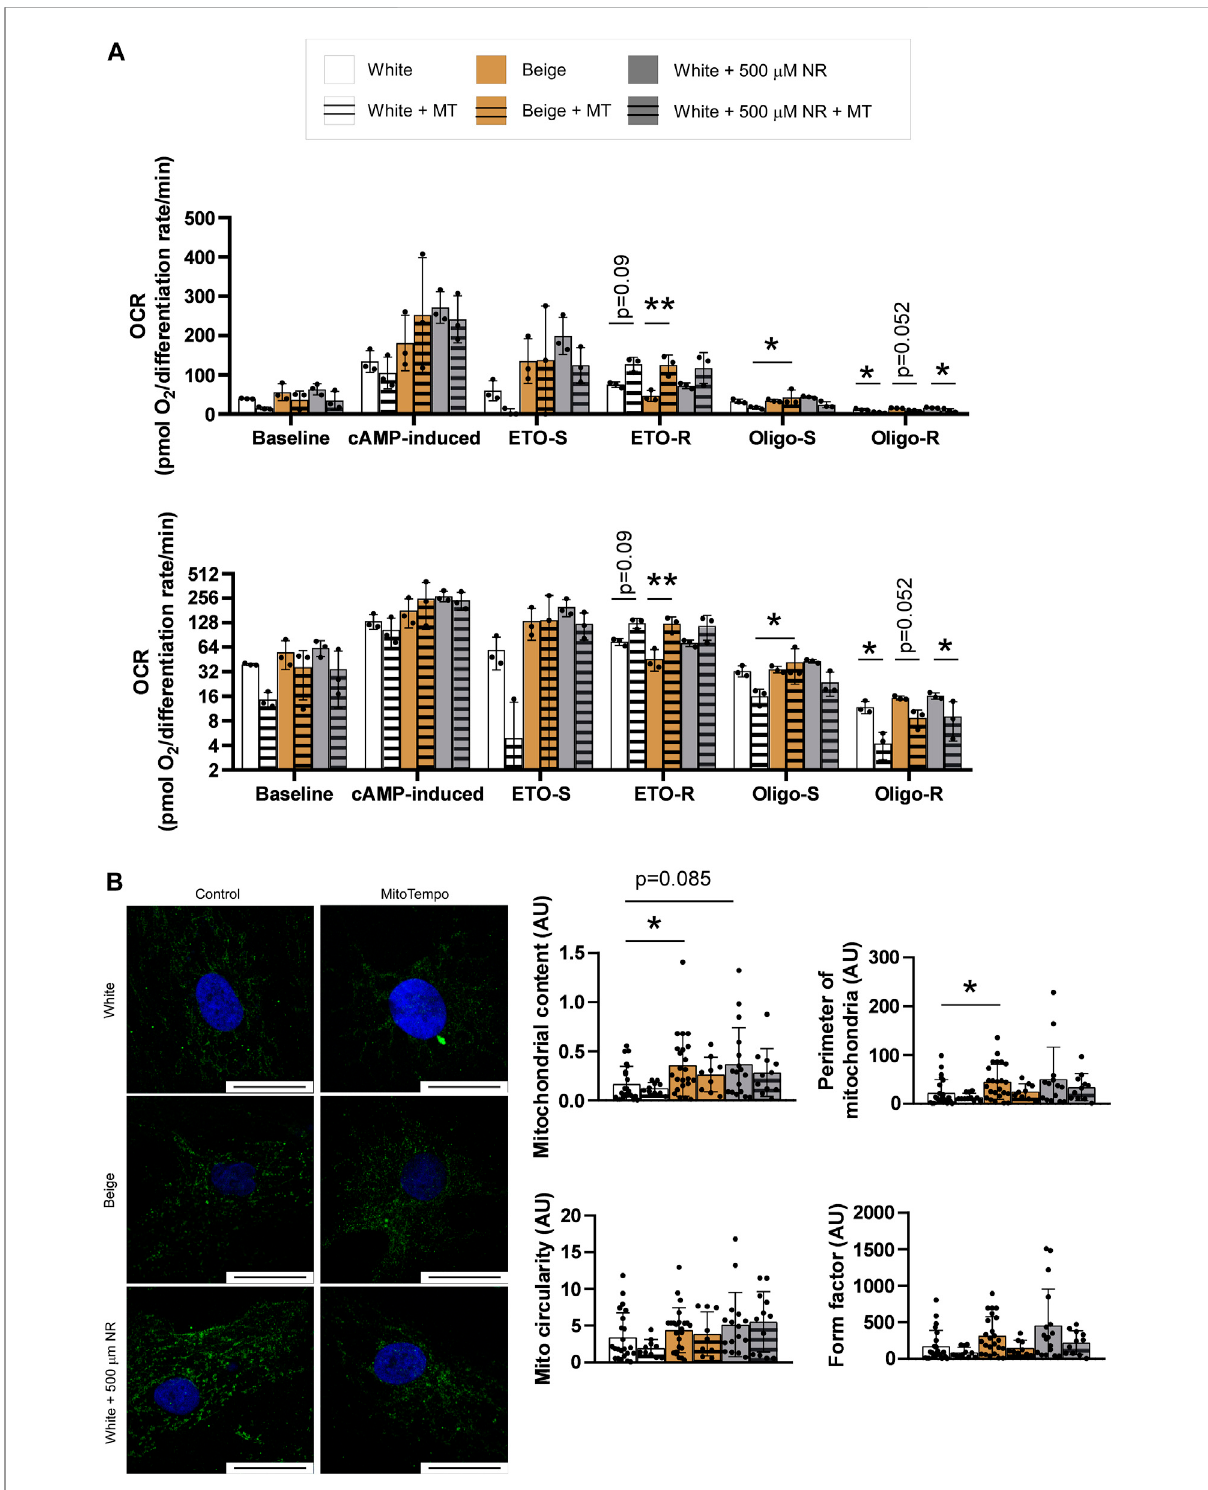
FIGURE 3 Mitochondria-derived reactive species production supports a switch towards uncoupled respiration. (A) Human adipose tissue-derived mesenchymal stem cells from three different donors were seeded in Seahorse plates and differentiated to adipocytes and mitochondrial oxidation was determined as described in Materials and Methods. The bottom graph depicts the same data on a log2-scale for better visibility (B) Human adipose tissue-derived mesenchymal stem cells from three different donors were seeded on coverslips, differentiated, stained with a